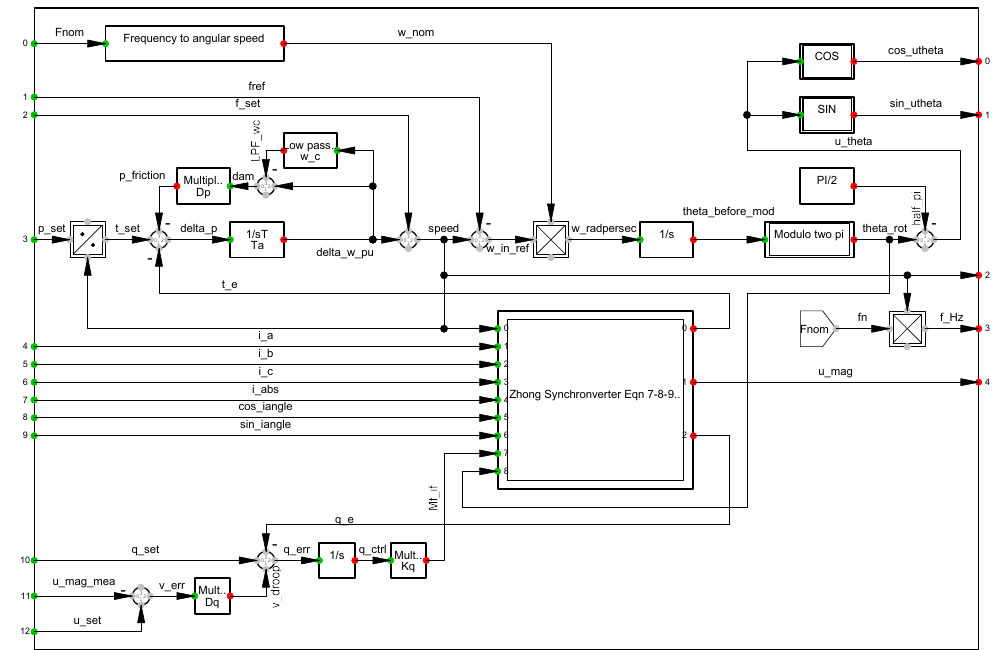
Figure A3. Synchronverter control. See Section 4.3 for details.